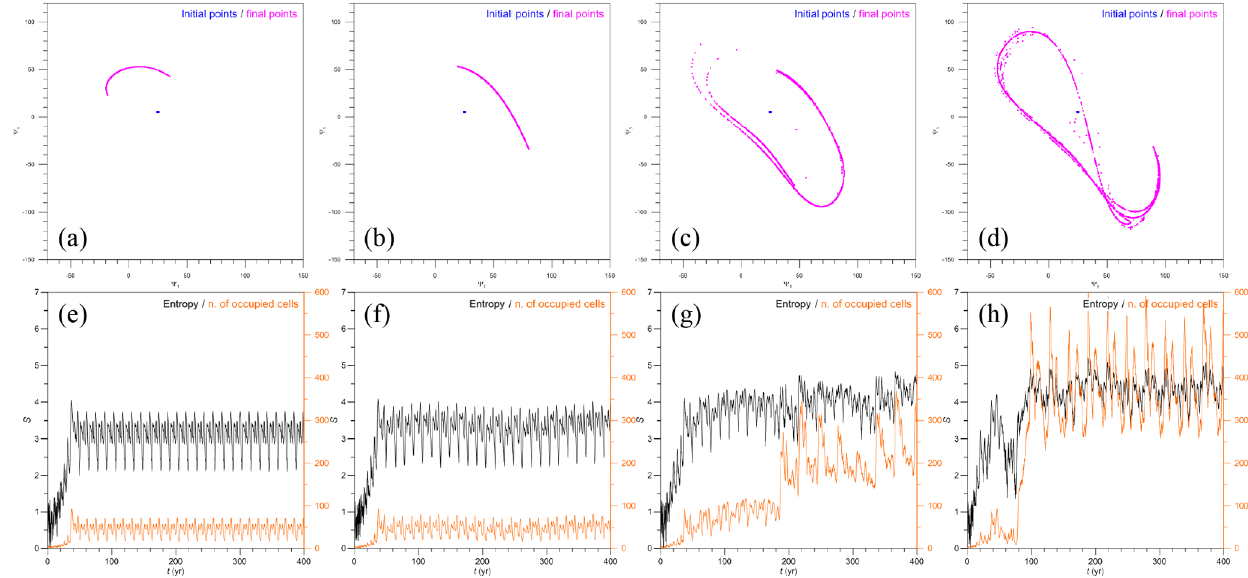
Figure 8. Same as Fig. 7, but for 15000 trajectories emanating at t = 0 from the small rectangle ϑ 2 of width (cid:49)(cid:57) = 2 centered at P 2